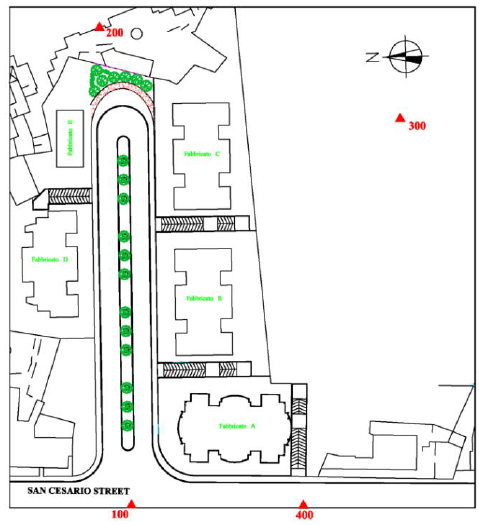
Figure 5. Scheme of the cornerstones of the network